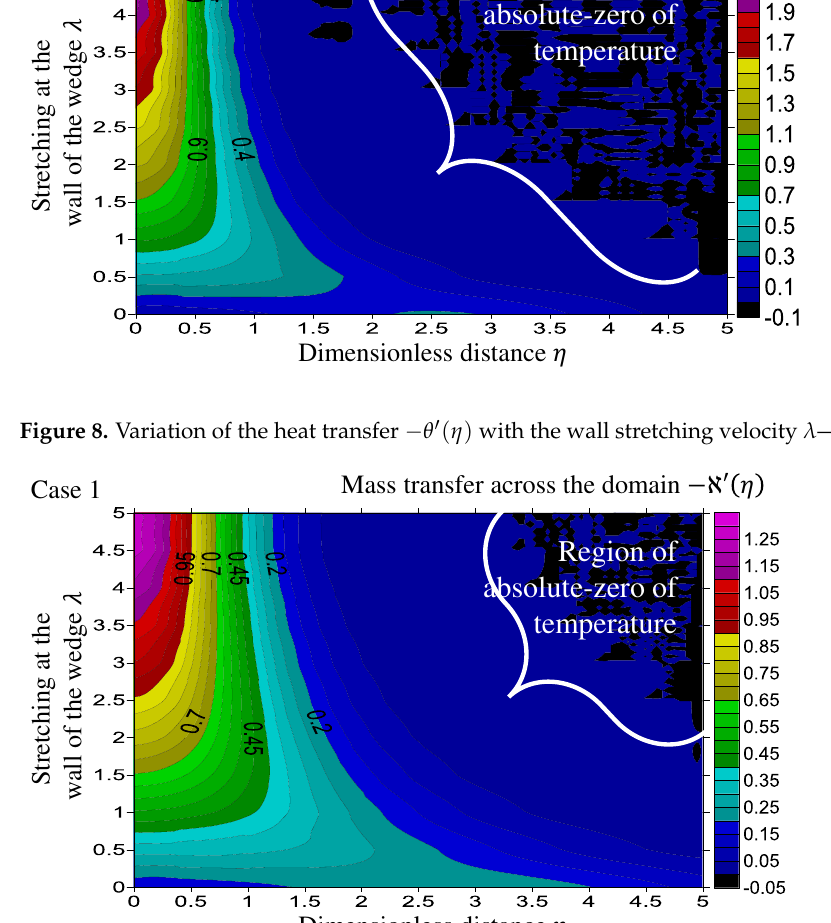
Dimensionless distance (cid:1) Figure 9. Variation of the mass transfer −ℵ (cid:48) ( η ) with the wall stretching velocity λ